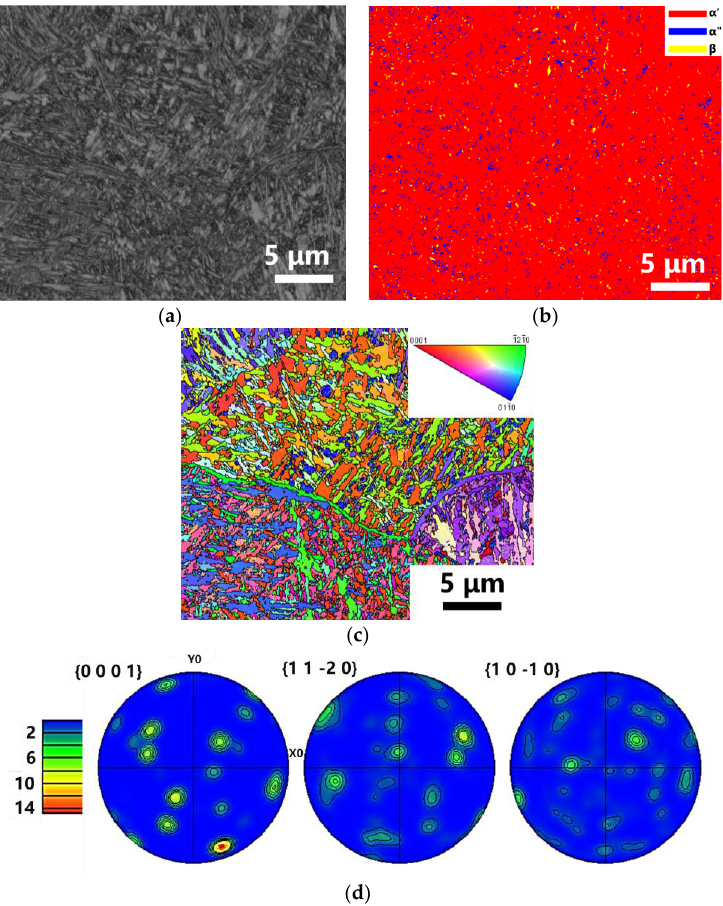
Figure 10. A series of images of EBSD results for sample S2 of LPBF Ti-Ta. ( a ) The position of the EBSD testing area, ( b )The phase distribution, ( c ) IPF maps and ( d ) pole figure of α′ martensite in sample S2 (v = 220 mm/s, E = 381 J/mm 3 ).